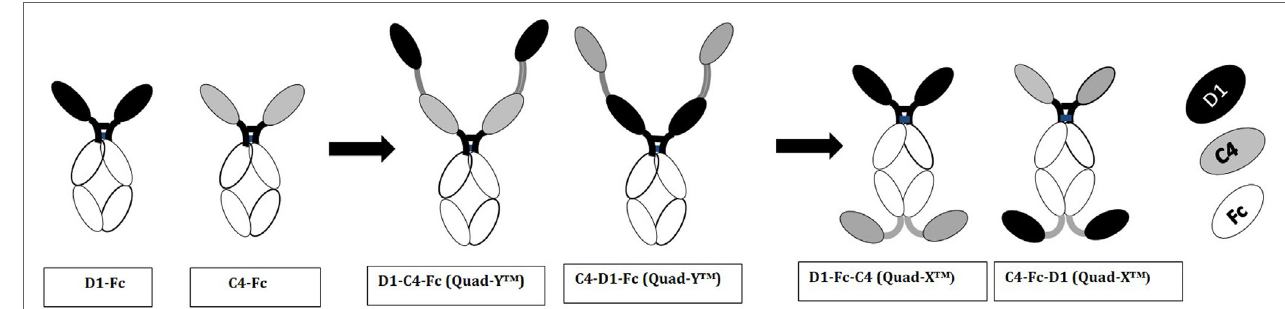
FigUre 4 | Diagrammatic representation of variable new antigen receptor (VNAR)-Fc constructs. VNAR-Fc constructs of D1 and C4 were generated by direct fusion of VNARs to the hinge of a wild-type human IgG1 Fc. These directly fused VNARs contained a Glycine-rich residue (GGGSGGGGSG) at the end of framework 4 region, and it is this glycine-rich residue that is fused to the hinge. Quad-Y ™ constructs are fused to the N-terminal position of the human Fc (as shown in the diagram). The VNARs in a Quad-Y format are linked by a flexible Gly4Ser linker (GGGGSGGGGSGGGGSGGGGS). The Quad-X ™ are VNARs fused to both N- and C-terminal ends of the wild-type human IgG1 Fc. The C-terminally fused VNAR is linked to the CH-3 fragment via a flexible Gly 4 Ser linker (as previously